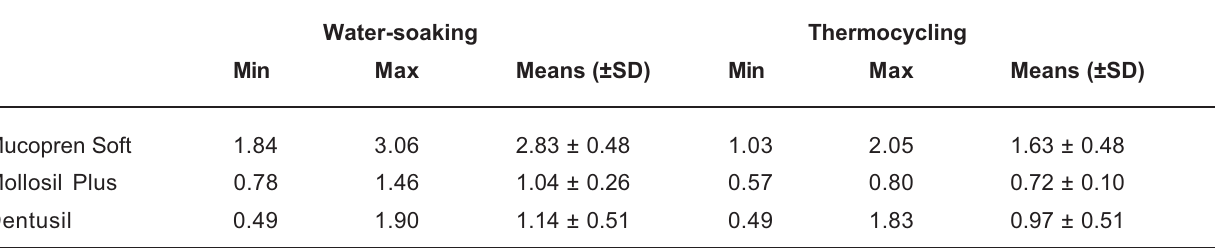
TABLE 2- Tensile bond strength (MPa) means (±standard deviation) for the water-soaked and thermocycled groups (N=60)